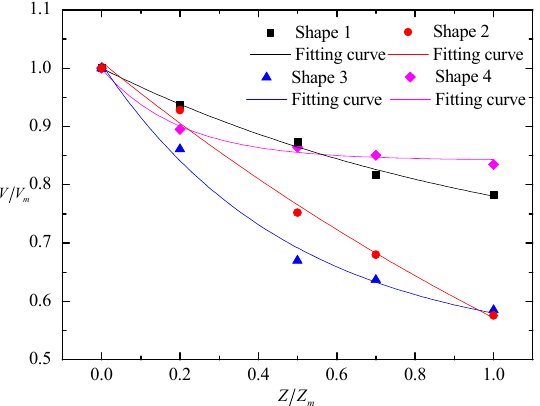
Figure 5. Nappe wind distribution in the vertical direction in the physical model test. V m is the maximum velocity of each shape.